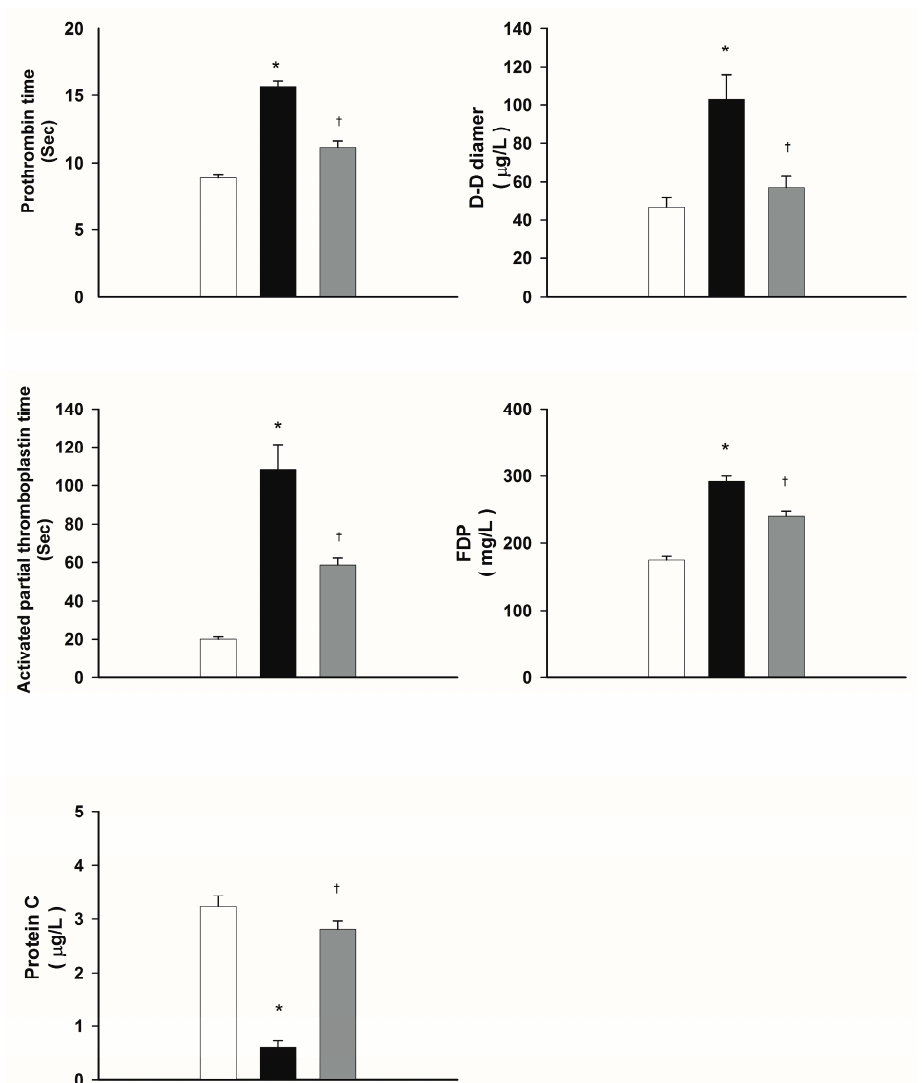
Figure 2. Effects of heat exposure (43 °C) on plasma levels of prothrombin time (PT), activated partial thromboplastin time (aPTT), fibrinogen degradation products (FDP), D-D dimer, and protein C in normothermic control rats (white bar), saline-treated (black bar) or dexamethasone-treated rats (grey bar, 8 mk/kg b.w., i.v.). * p < 0.05, in comparison with normothermic control rats; † p < 0.05, in comparison with saline-treated rats (ANOVA followed by Duncan’s test). The values were obtained 85 min after the initiation of heat exposure (or 15 min after the onset of heat stroke) in heat stroke rats or the equivalent time in normothermic controls. Bars are each the mean ± S.E. of 8 rats for each